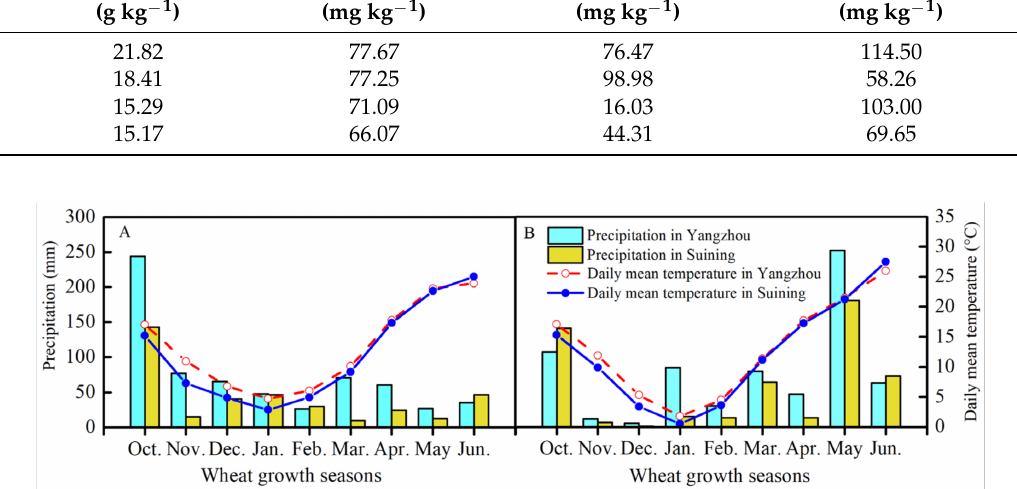
Figure 1. Precipitation (mm) and daily mean temperature ( ◦ C) during the wheat growth period in southern (Yangzhou) and northern (Suining) areas of the Yangtze River basin, China, in 2016 to 2017 ( A ) and 2017 to 2018 ( B